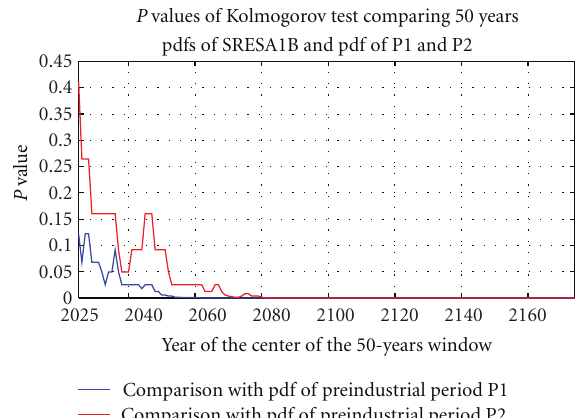
Figure 9: P values of Kolmogorov test comparing the pdfs during 21st and 22nd centuries taking windows of 50 years with the pdfs of the preindustrial periods P1 (blue) and P2 (red). Values smaller than 0.1 means that the pdfs are statistically di ff erent at 10%. The P -values are mapped at the middle of the sliding